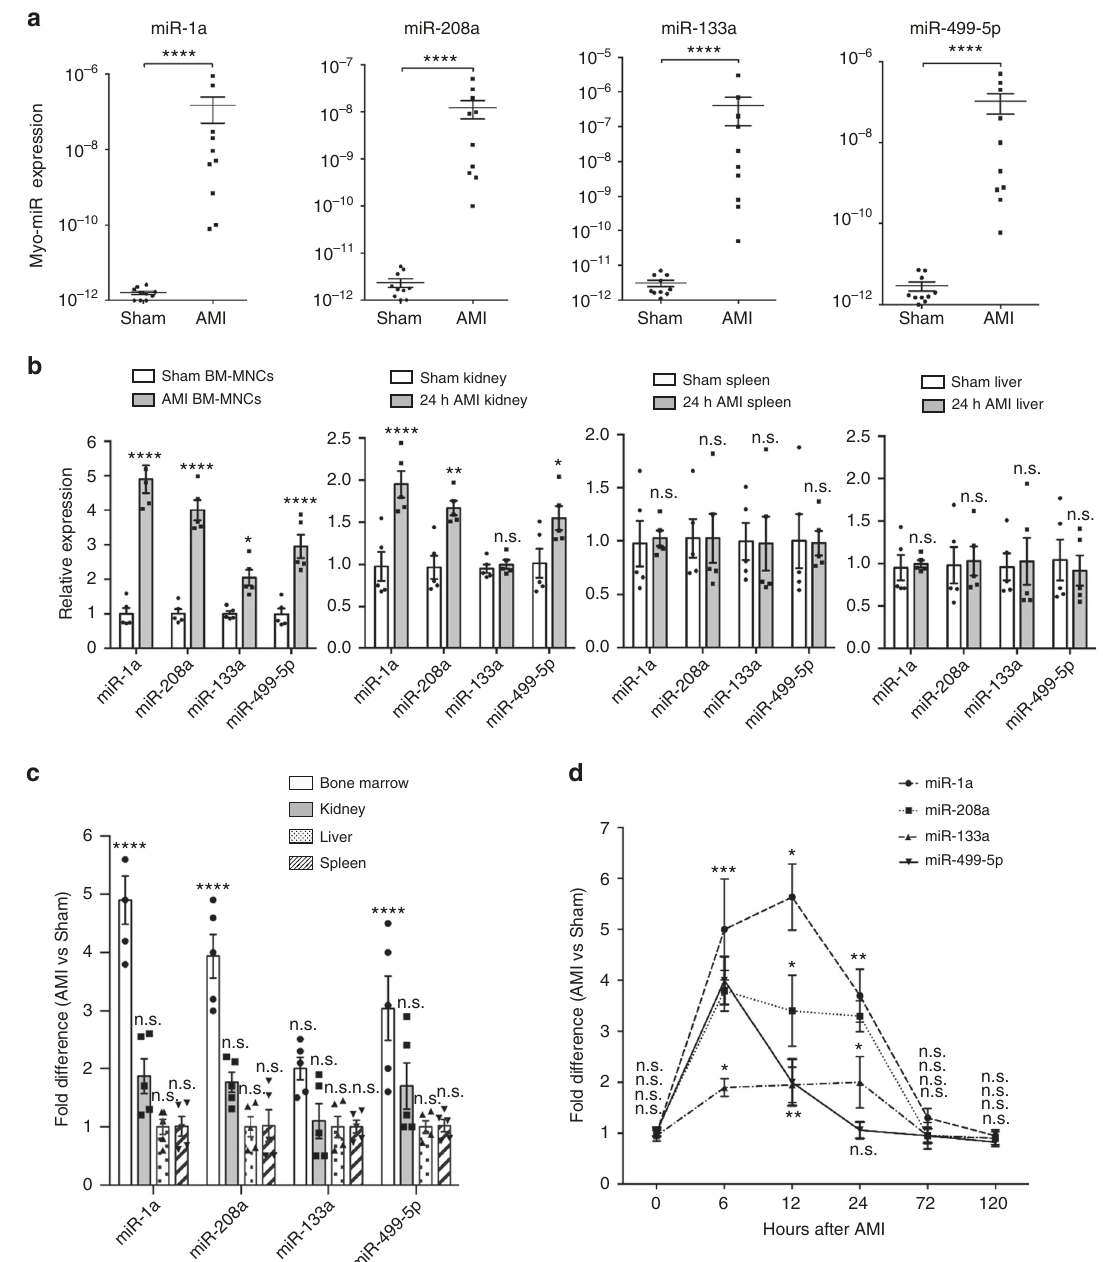
Fig. 1 Myo-miRs are released into PB following AMI and transported into BM-MNCs. AMI and Sham surgeries were performed in C57BL/6 mice; then at various time points, the plasma, BM-MNCs, and different organs were isolated and subjected to qRT-PCR analyzes of myo-miRs, miR-1a, 208a, 133a, and 499-5p. a myo-miR levels in the plasma 6 h post-surgery ( n = 10 animals per group). b myo-miR levels in the BM-MNCs, kidney, spleen, and liver 12 h post- surgeries, expressed relative to the levels in the intact controls ( n = 5 animals per group), and c the fold difference in AMI vs. Sham mice ( n = 5 animals per group). * p < 0.05, ** p < 0.01, *** p < 0.001, **** p < 0.0001 vs. Sham; n.s., no signi fi cant. d The fold difference of myo-miR levels in the BM-MNCs of AMI vs. Sham mice at 0, 6, 12, 24, 72, and 120h post-surgery. * p < 0.05 ** p < 0.01, *** p < 0.001 vs. Sham at same time point. n = 5 animals per group per time point. An unpaired t test was used in a and a two-way ANOVA was used in b , c , and d for statistical analysis. Error bars represent mean ±s.e.m